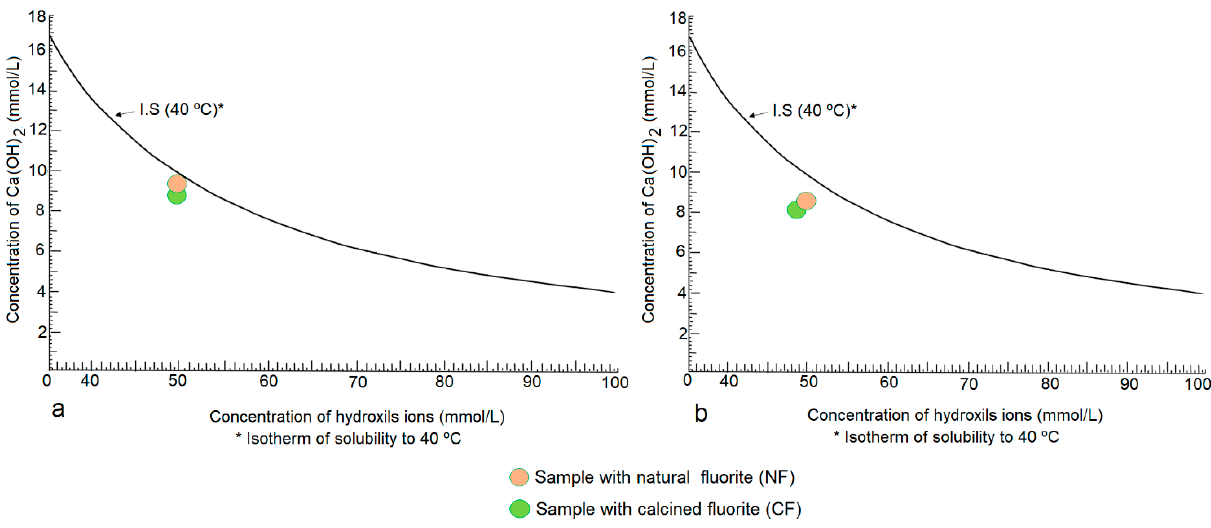
Figure 5. Evolution of the pozzolanic behaviour of the NF and CF samples analysed: ( a ) at 8 days; ( b ) at 15 days.